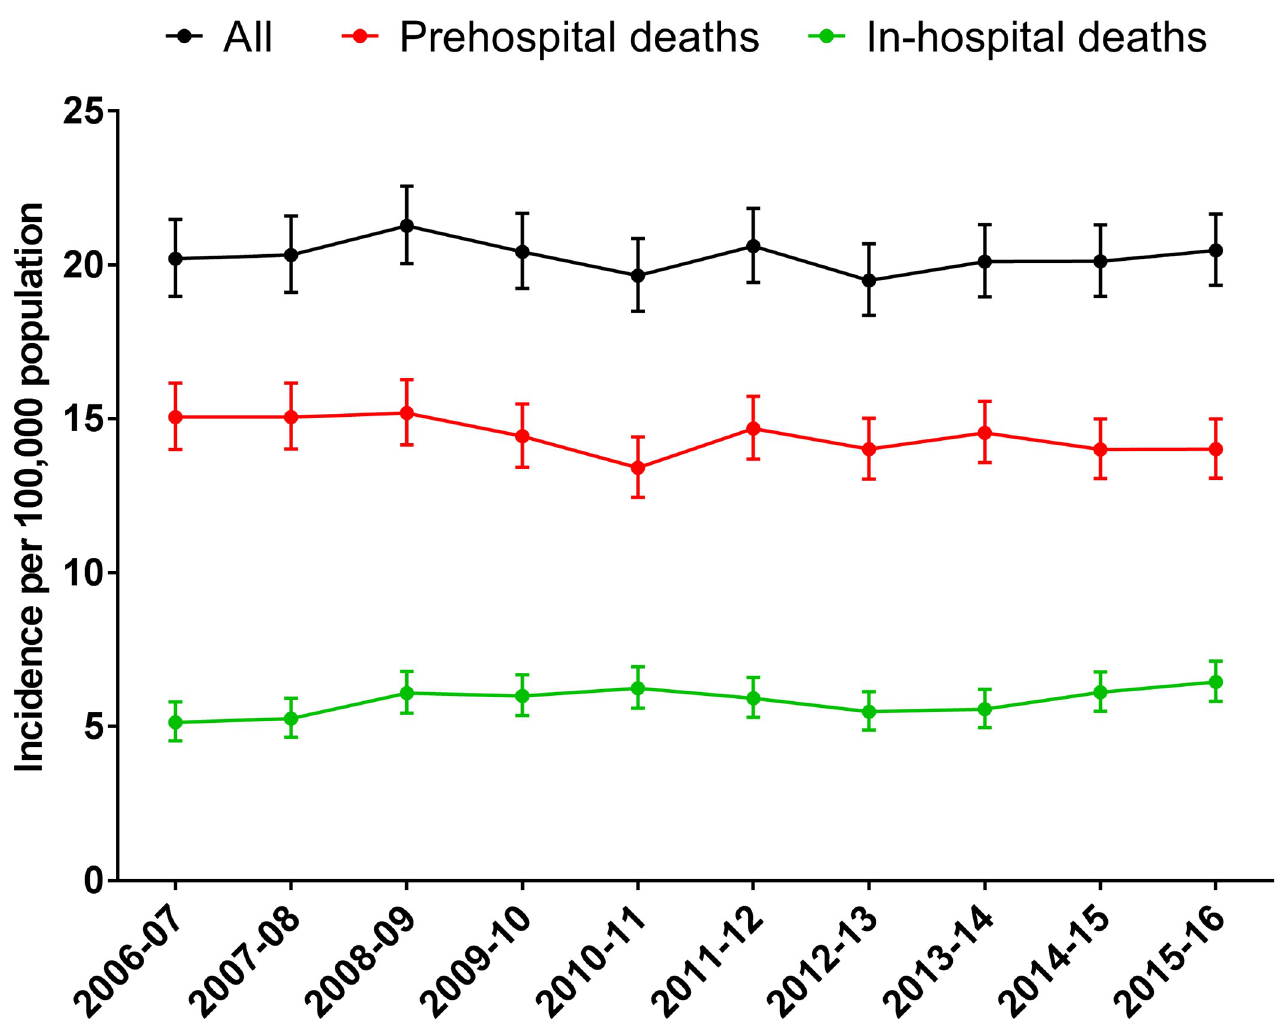
Fig 2. Incidence of out-of-hospital and in-hospital trauma